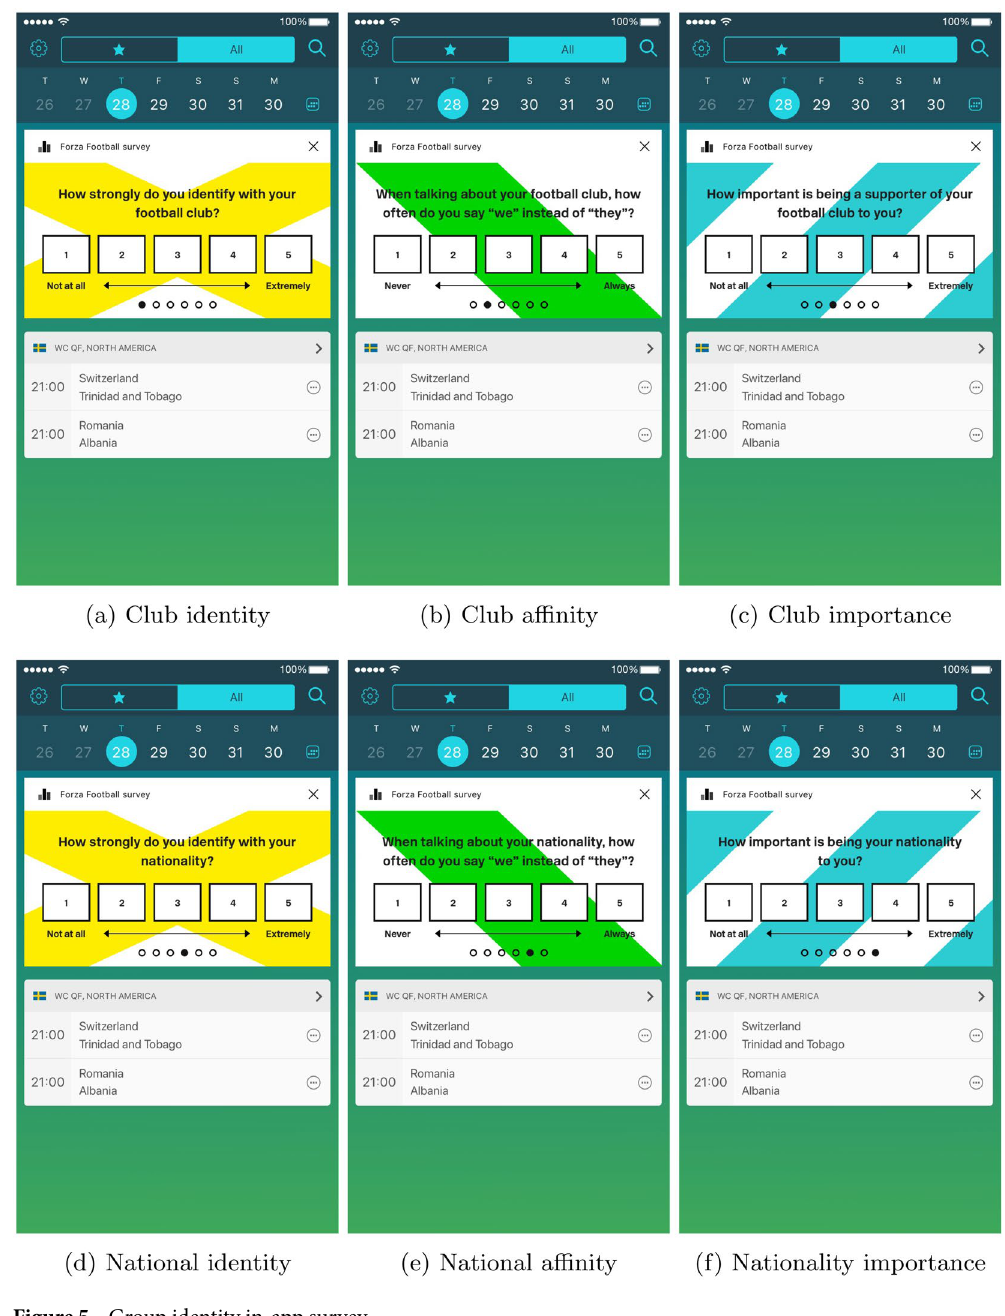
Figure 5. Group identity in-app